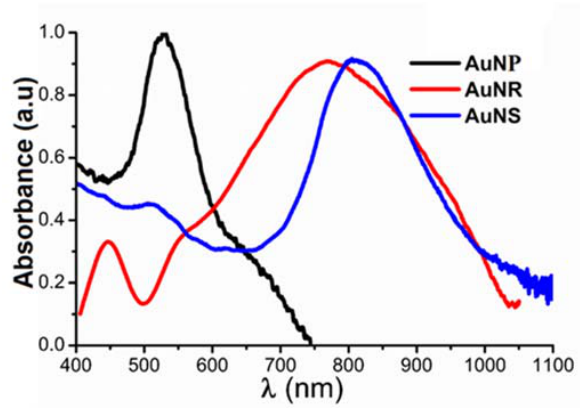
Figure 3. Typical UV ‐ Vis ‐ near infrared region (NIR) absorption spectra of AuNPs (18 nm), AuNR and AuNS. Note that the spectra of the AuNR and AuNS peak at the near infrared region, around 800 nm.